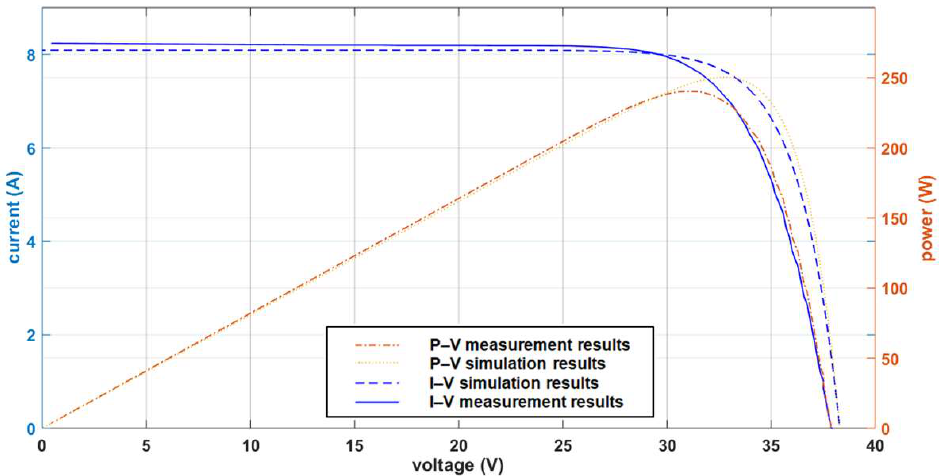
Figure 4. Verification results for measuring point P1 (see Table 2).